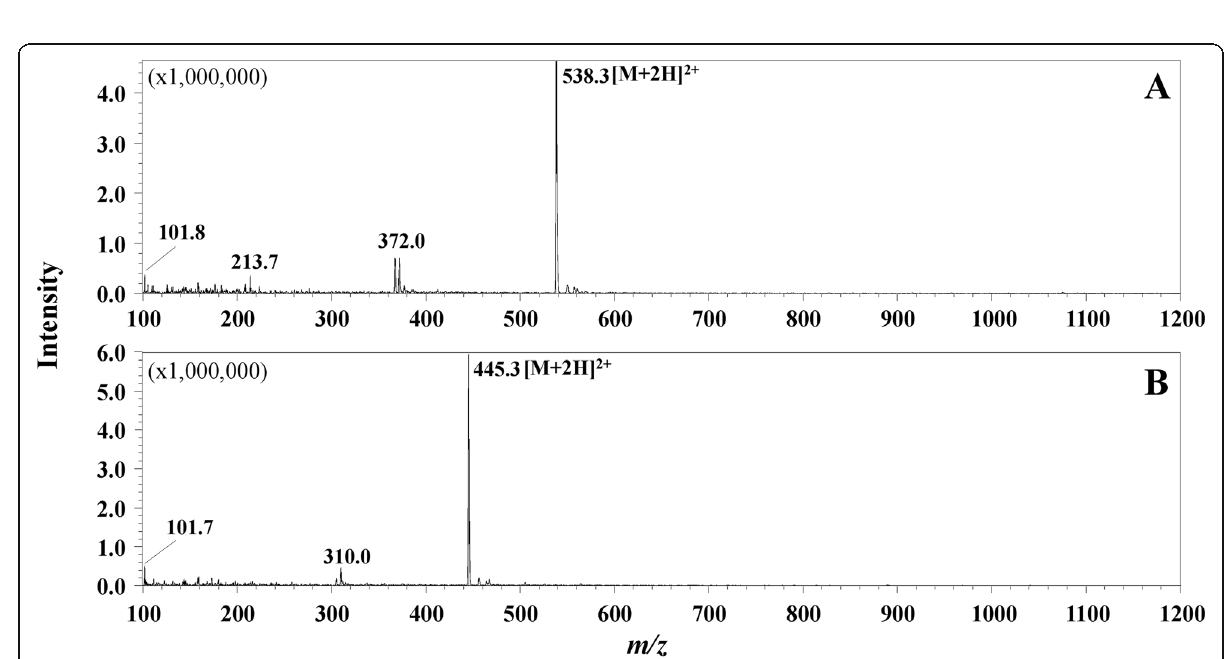
Fig. 3 Mass spectral patterns of SNAP-8 ( a ) and the IS ( b ) by LC-MS/MS with ESI